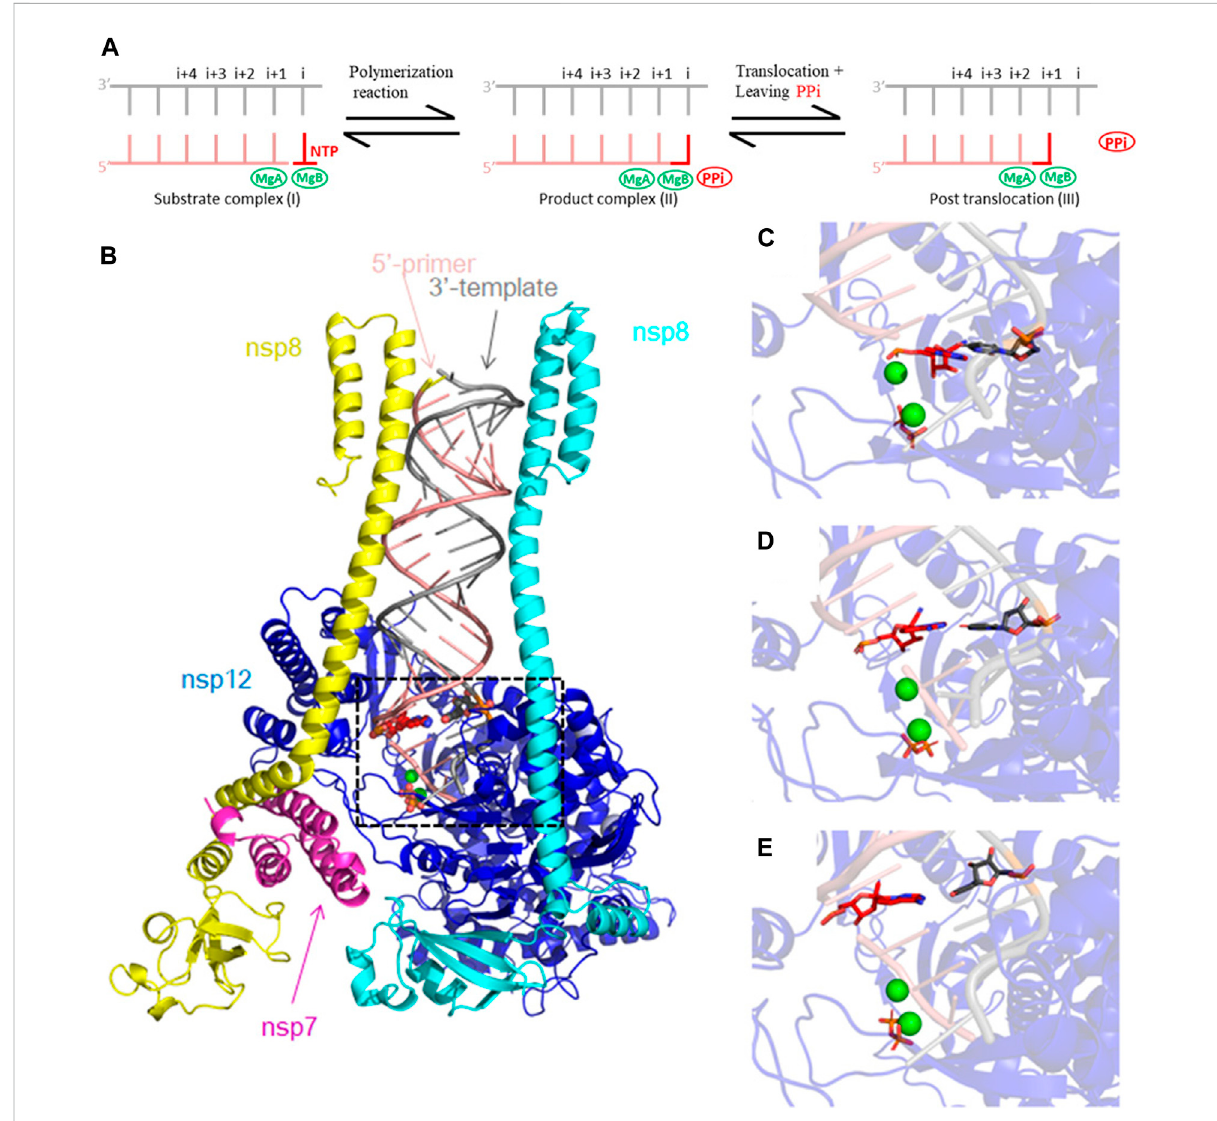
FIGURE 1 Cryo-EM RTC 6xez structure of SARS-CoV-2 used for our MD simulations. (A) Schematic diagram of RNA replication and translocation processes.The replicationstarts with NTP binding to position i (I).Phosphodiester bondis formed, and thenucleotide isincorporated into the3 ′ end of the primer. PPi is cleaved from NTP (II). Upon release of PPi, the 3 ′ end of the primer translocates by one nucleotide (III). (B) Our MD simulation model includes the 6xez structure after removal of two nsp13 helicase subunits, consisting of subunits of nsp7 (magenta), nsp8 (yellow and cyan),nsp12(blue)andtheRNAtemplate/primerduplex(pinkandsilver).Mg 2+ ionsareshowningreen,andPPiisshowninorangeandRMPisshown in red. (C – E) Close-up views of the modeled RMP at position i + 1, i + 2 and i + 3 used in this